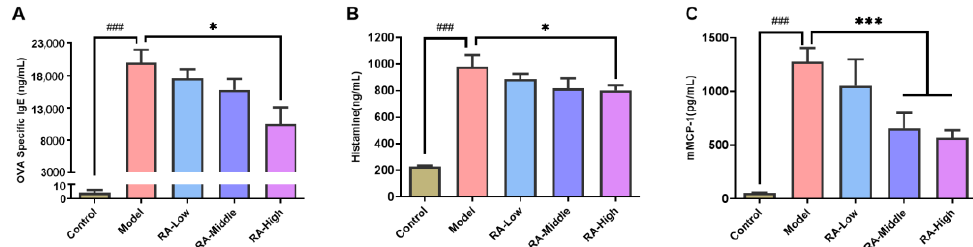
Figure 2. Effects of RA on OVA-sIgE and anaphylactic mediators of OVA-sensitized mice. ( A ) Effects of RA on OVA-sIgE. At day 41, the serum from eyeball blood was collected and the OVA-sIgE was measured using an ELISA Kit. ( B ) Effects of RA on the histamine levels. Serum from the caudal vein of mice was collected at 1 h after the last challenge. The histamine levels were measured using ELISA. ( C ) Effects of RA on mMCP-1 levels. The mMCP-1 levels were measured by ELISA. ### p < 0.01, compared with the PBS group; * p < 0.1, *** p < 0.01 compared with the OVA model group.